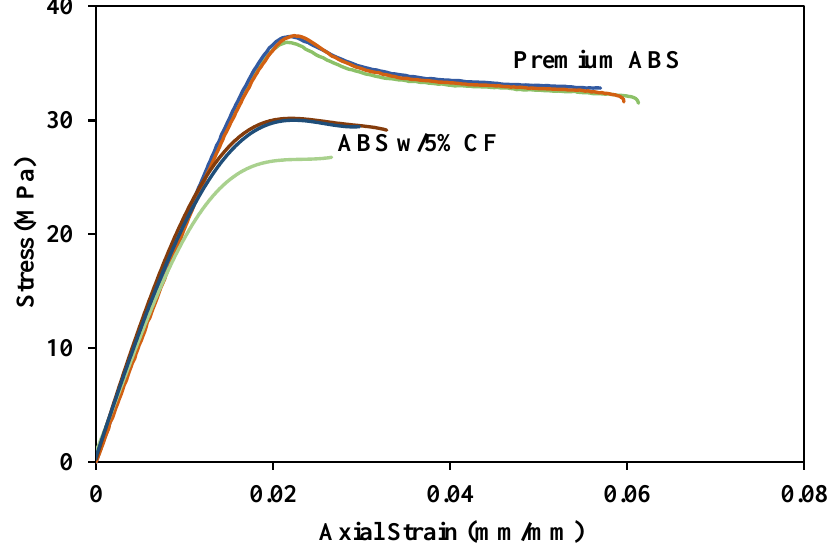
Figure 17. Tensile response of Premium ABS and ABS w/5%CF printed at a 0.1 mm layer height.